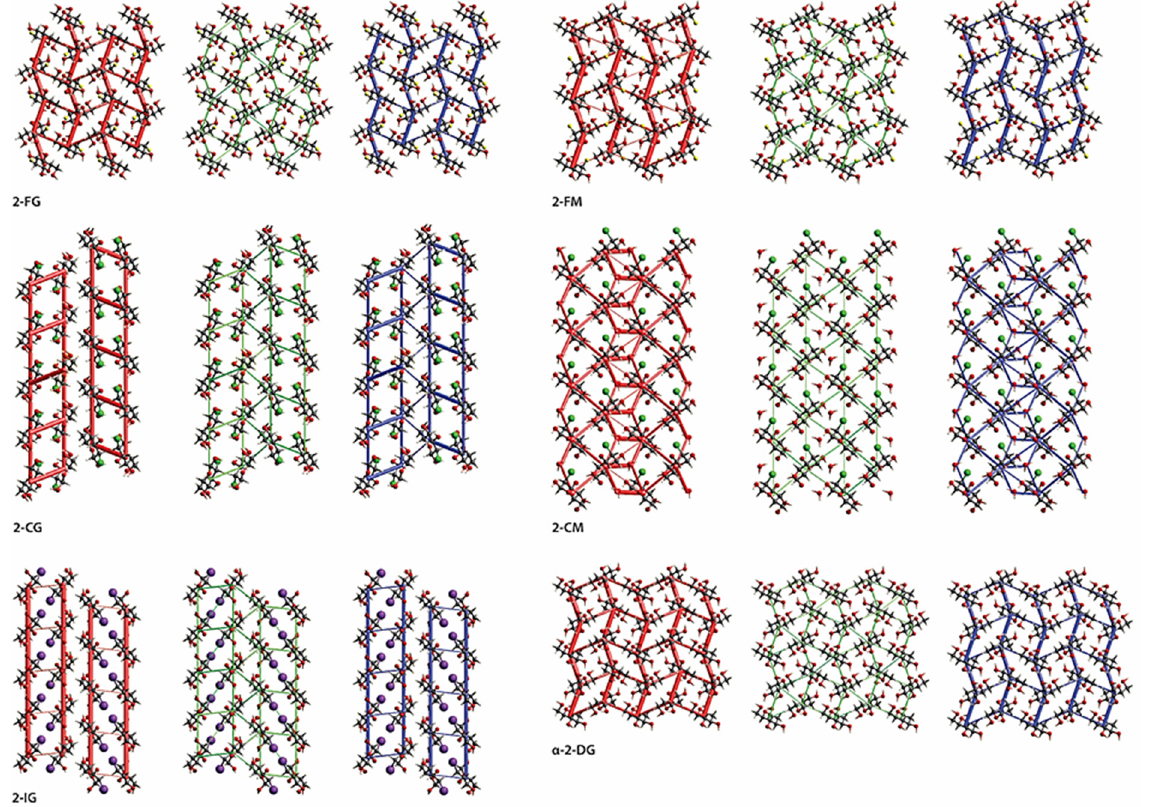
Figure 6. Energy frameworks viewed along a direction for the electrostatic (red) and the dispersion (green) components and the total interaction energy (blue).